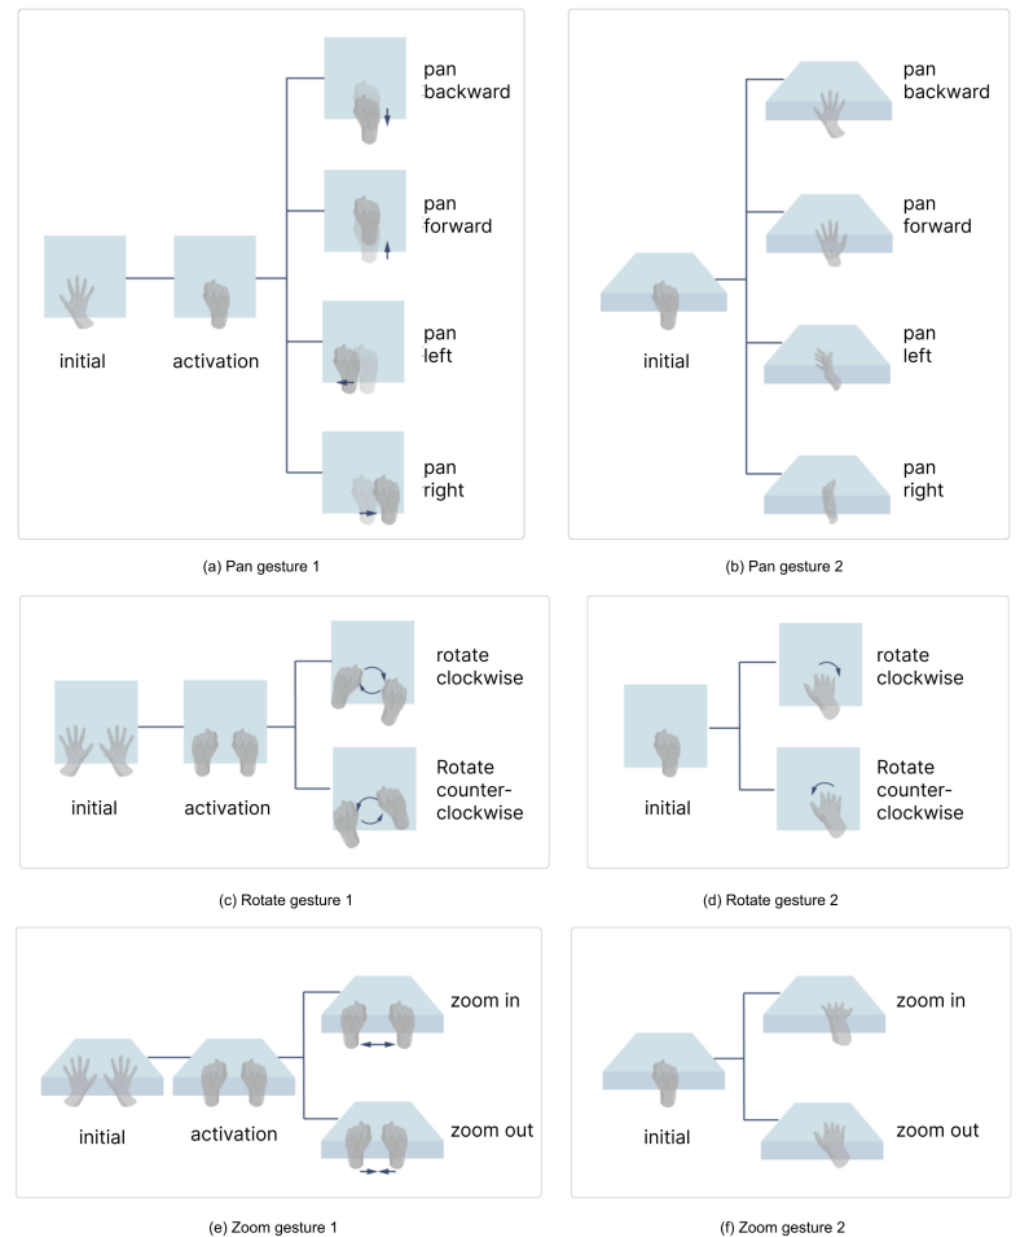
Figure 5. Two groups of gestures designed according to heuristic gesture library. The sub-tasks are presented in random order, and the subjects are permitted to prac- tice each task before the formal experiment. They become familiar with the VR environ- ment, gesture operation, and experimental requirements during the training process. The volunteers can give their opinions and suggestions regarding gestures and interactions throughout the experiment. The subjects can control the rest time for each sub-task to reduce tiredness. During the experiment, subjects are instructed to perform the goal task as rapidly as feasible. The software records the time cost of different operations. Only primary handedness is used in the investigation to assure the scientific validity of the experimental findings and eliminate the factor difference between right-handed and left-handed